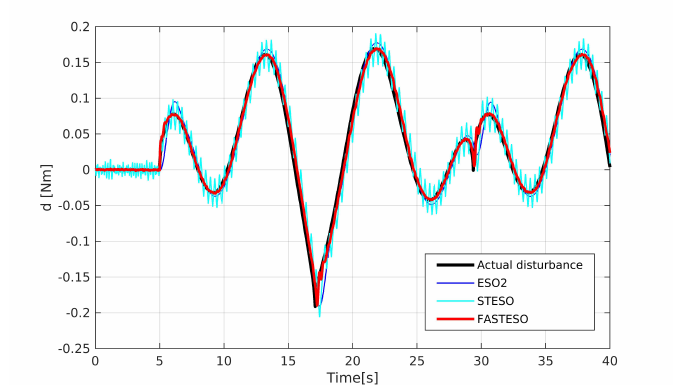
Figure 10. Estimation results from ESO2, STESO, and FASTESO with scalar a = 5.